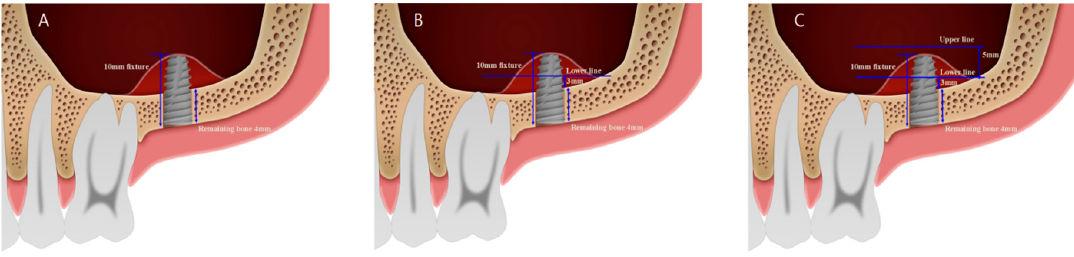
Figure 2. Diagram of volumetric analysis. ( A ) 10-mm long fixture; the remaining bone is 4 mm; the 6-mm part of the fixture would be exposed. ( B ) The lower line could be drawn 3 mm above the inferior border of the maxillary sinus. ( C ) The superior line could be drawn 5 mm above the first inferior boundary of the lateral